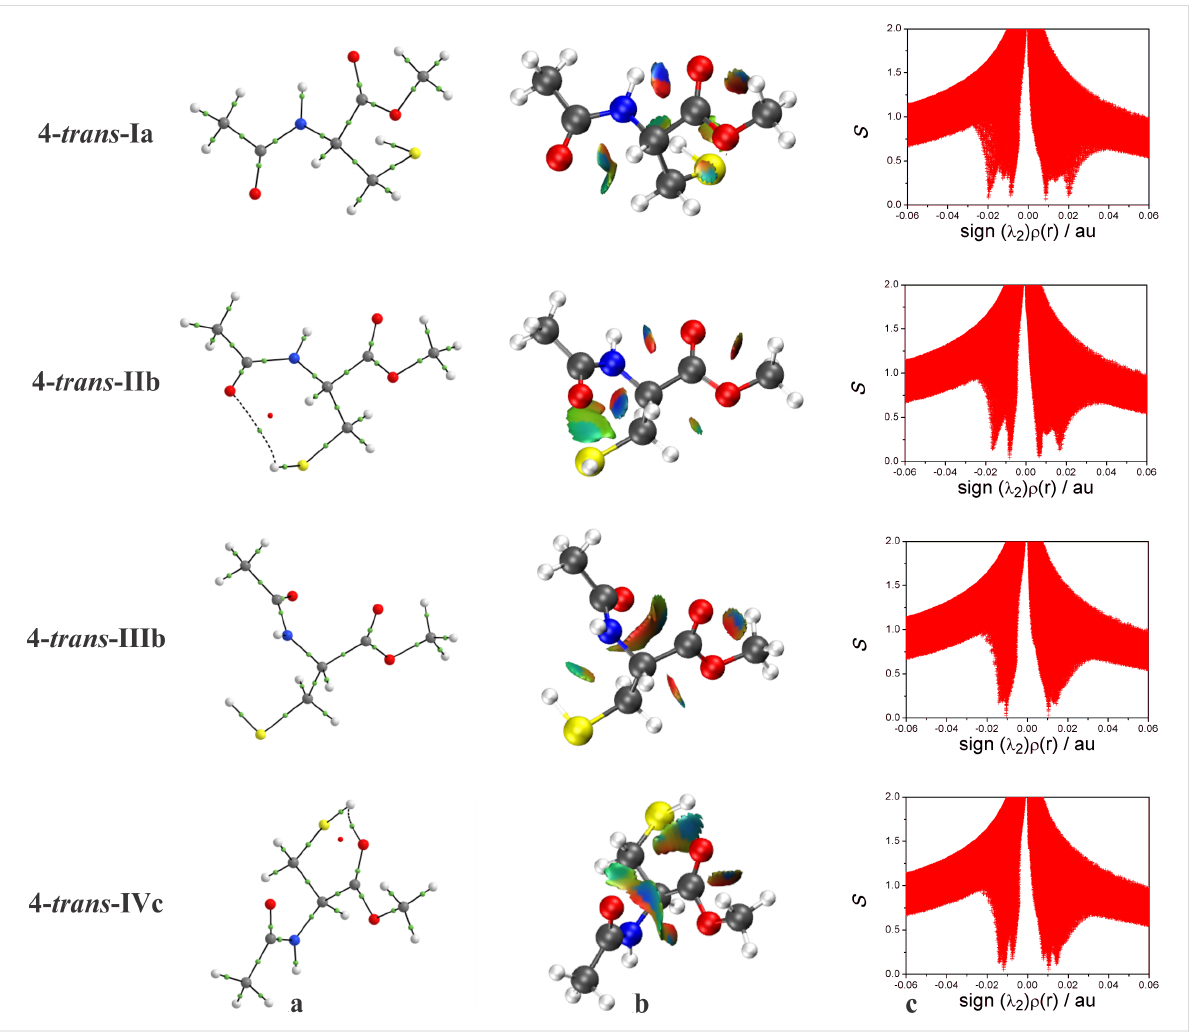
Figure 5: (a) QTAIM molecular graphs; (b) NCI isosurfaces generated with S = 0.6 au and blue − green − red scaling from − 0.02 < ( λ 2 ) ρ (r) < 0.02 au, and (c) NCI plots of the reduced density gradients S versus sign ( λ 2 ) ρ (r) for the conformers of 4 .